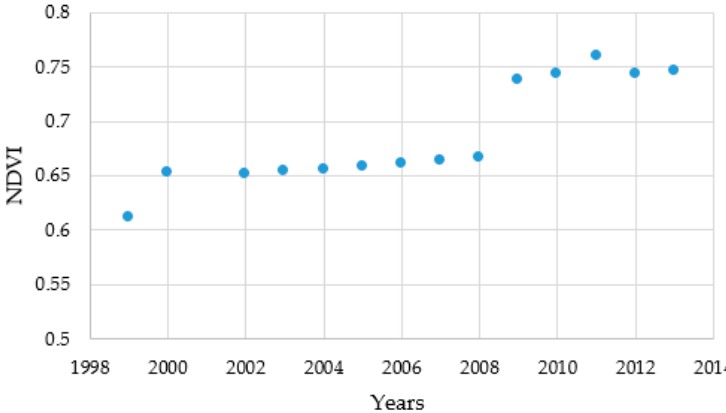
Figure 5. Trend of normalized difference vegetation index (NDVI) changes in Fuling District, Chongqing, 1999–2013.